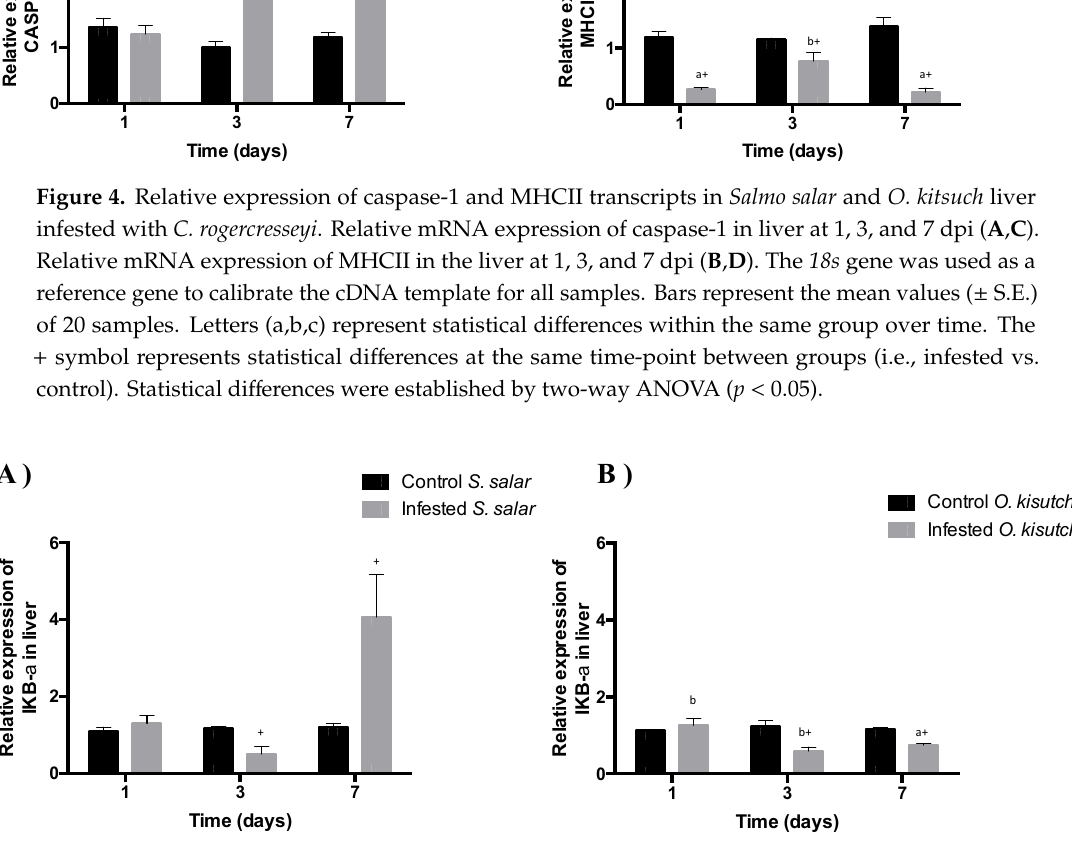
Figure 5. Relative expression of I-kappa-B-alpha (IkB- α ) transcripts in Salmo salar and O. kitsuch infested with C. rogercresseyi . Relative mRNA expression of IkB- α in liver at 1, 3, and 7 dpi ( A , B ). The 18s gene was used as a reference gene to calibrate the cDNA template for all samples. Bars represent the mean values ( ± S.E.) of 20 samples. Letters (a,b,c) represent statistical di ff erence within the same group over time. The + symbol represents statistical di ff erences at the same time-point between groups (i.e., infested vs. control). Statistical di ff erences were established by two-way ANOVA ( p < 0.05).